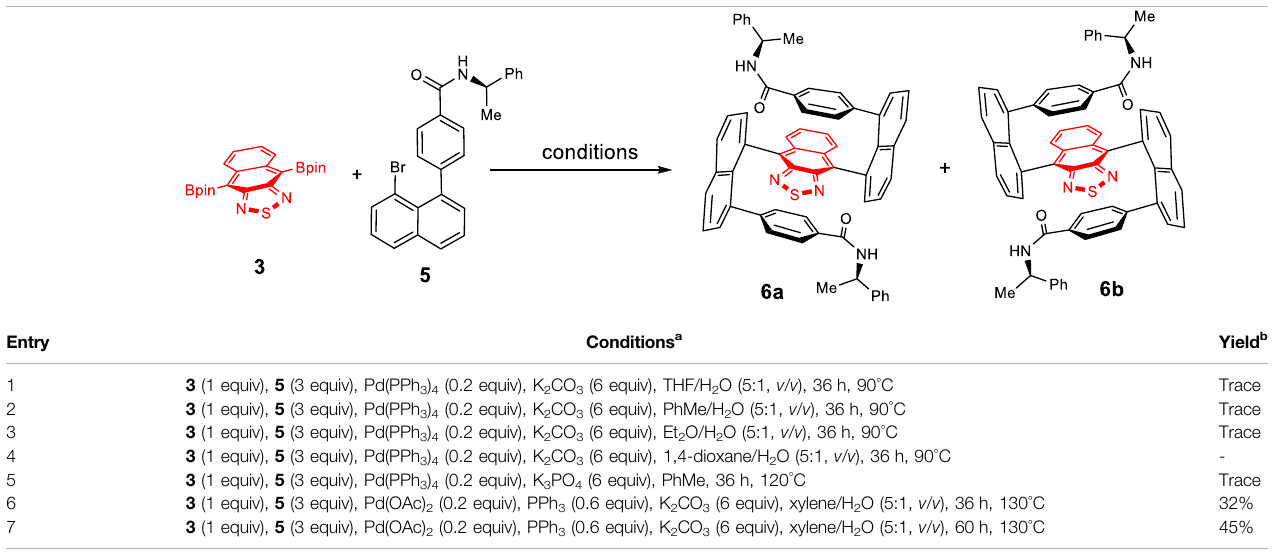
TABLE 1 | Optimization of the reaction conditions for the palladium-catalyzed Suzuki coupling of 3 with 5